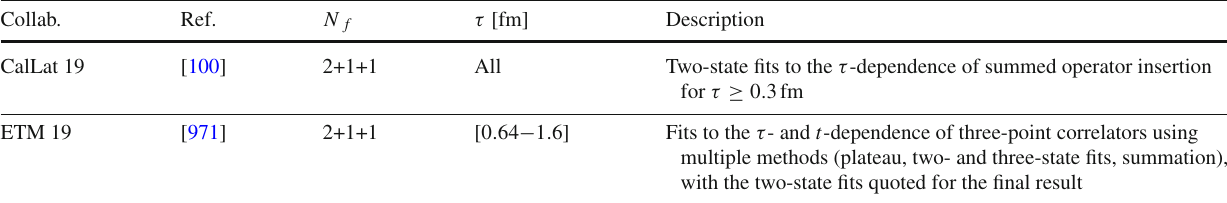
Table 182 Control of excited state contamination in determinations of the isovector axial, scalar and tensor charges with N f = 2 + 1 + 1 quark flavours. The comma-separated list of numbers in square brackets denote the range of source-sink separations τ (in fermi) at each value of the bare coupling Collab.